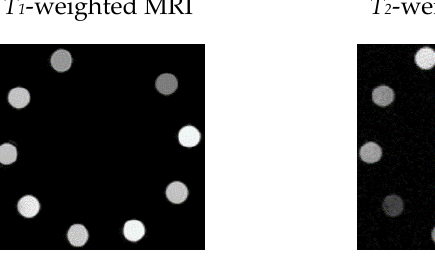
Figure 4. MRI phantoms of HSA-NIT conjugates imaged in a 7 T BioSpec 70/30 USR magnet at RT. T 1 and T 2 -weighted MRI phantoms at HSA-NIT concentrations (0.2 mM and 0.5 mM). Acquisition parameters are provided in ESI.